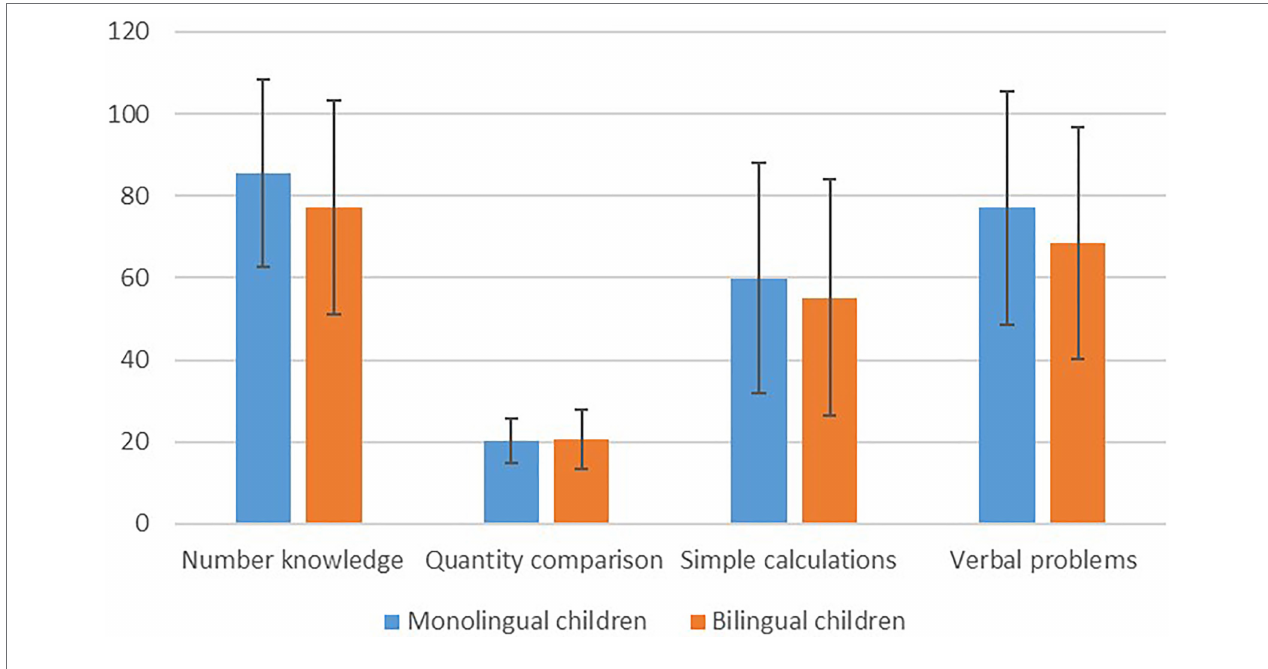
FIGURE 2 | The performance of monolingual and bilingual children on the different early numeracy factors.